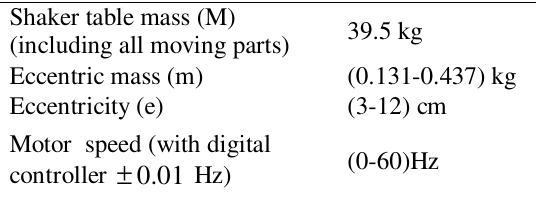
Specifications of the vibration